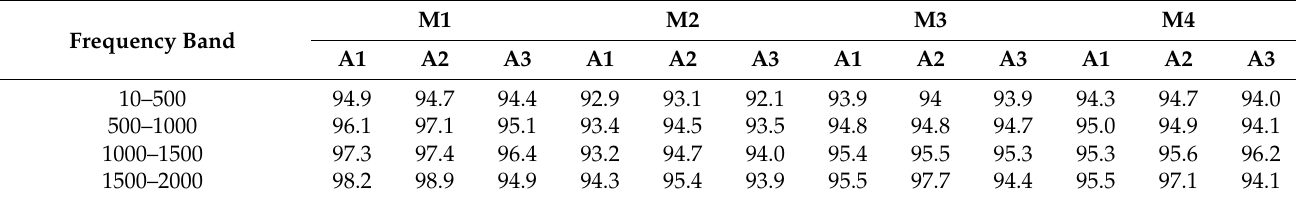
Table 7. The overall vibration acceleration level in each frequency band